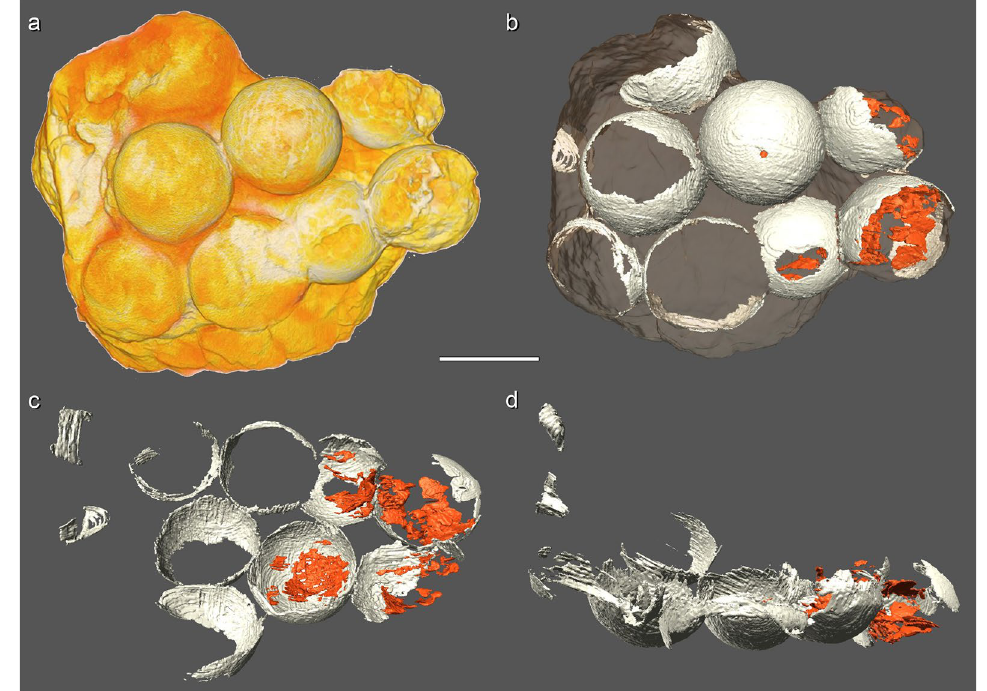
Figure 3. CT scans of the best-preserved egg-clutch (CPPLIP 1798). ( a ) 3D rendering of the bottom of the clutch in CPPLIP 1798. ( b ) General view of the clutch at the same orientation, showing the external part of the lower hemisphere of the eggs. ( c ) Top view of the lower egg row, showing the inner part of the lower hemisphere of the eggs. ( d ) Lateral view of CPPLIP 1798, showing lower egg row with higher shells at both ends and part of the upper egg row. In dark orange, eggshell fragments within the eggs. Note that the incompleteness (“holes”) of some eggs in B and C are due to the lack of the eggshells and/or poor resolution of the CT scan. In A the shape of each egg is maintained due to the sedimentary internal mold. Scale bar 10